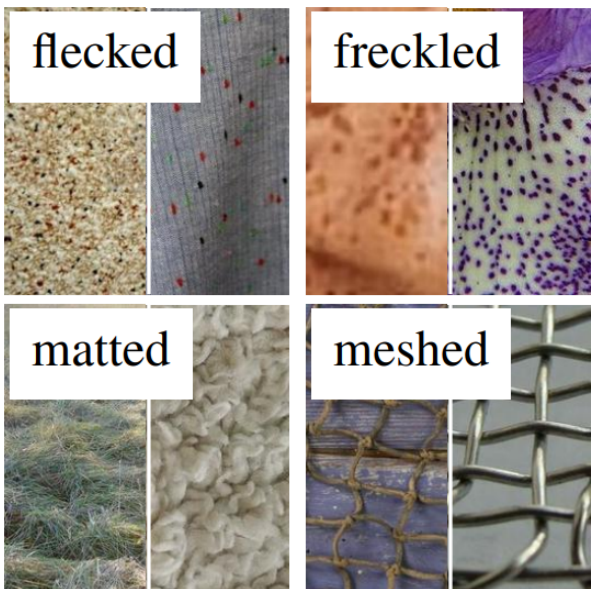
Figure 10. A sample from the DTD dataset [28]. An example of why rotation based pretext tasks may not work